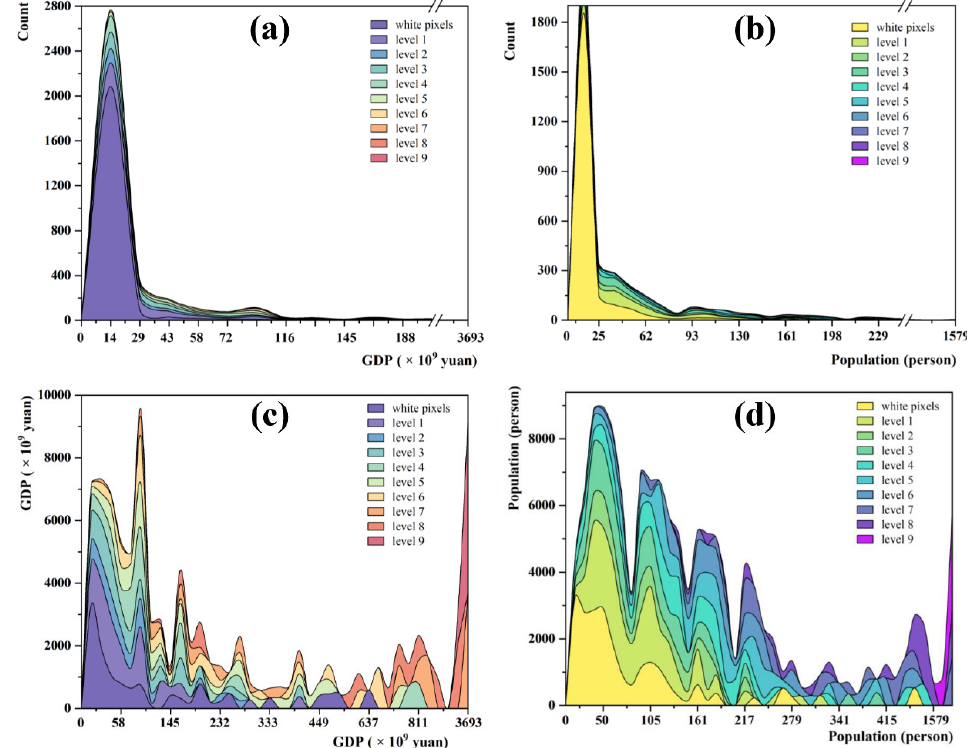
Figure 7. The distribution of GDP and the population in each grid cell at different levels of climate change impact and the corresponding sum of the GDP and population in each grid cell at different intervals. ( a ) The number of pixels at different GDP intervals. ( b ) The number of pixels at different population intervals. ( c ) The sum of GDP in each grid cell at different intervals. ( d ) The sum of the population in each grid cell at different intervals.